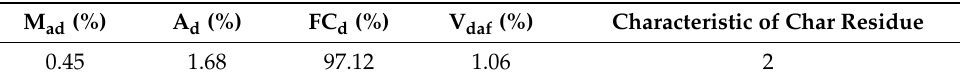
Table 2. Entire quality analysis of coke (M ad : air drying base content; A d : ash content; V daf : volatile content; FC d : fixed carbon